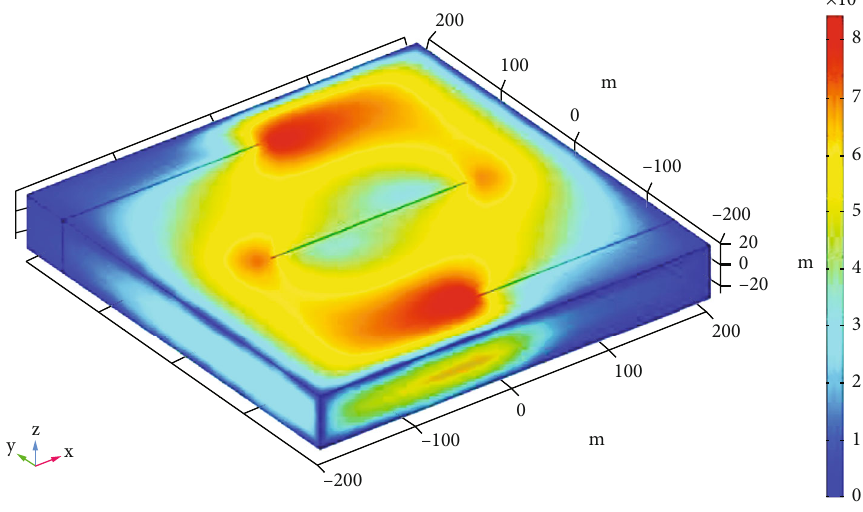
Figure 5: Spatial distributions of e ff ective stress of the prototype and the model in the x